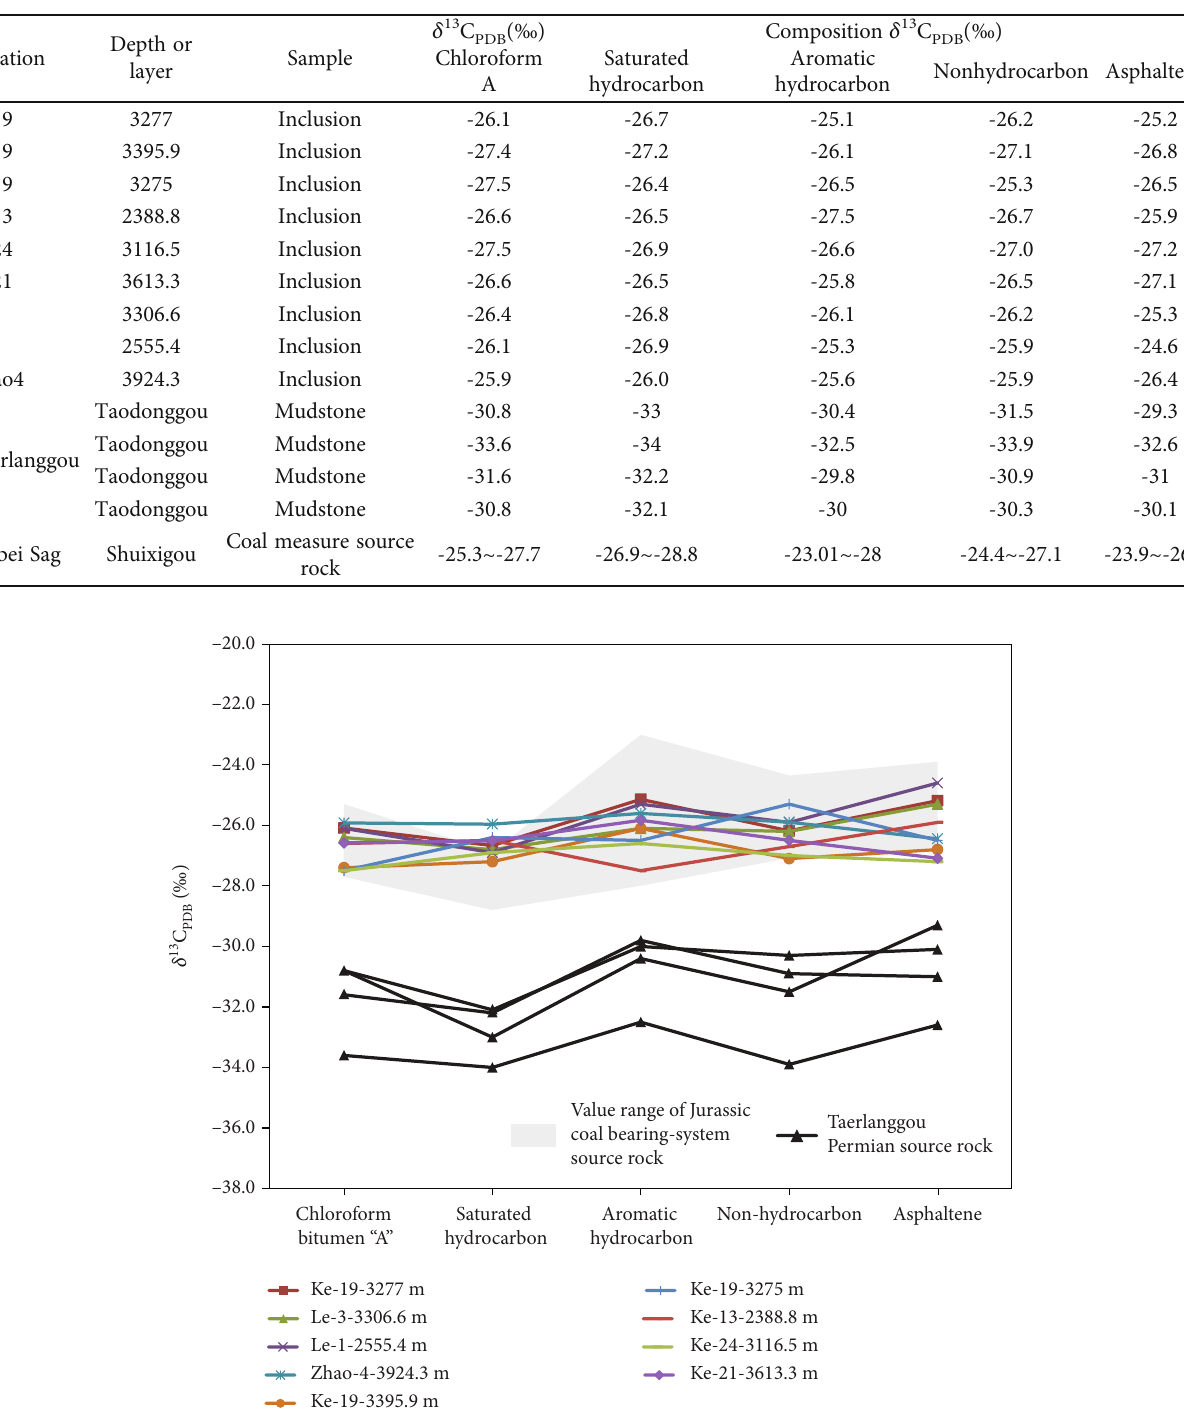
Figure 10: The stable carbon isotope comparison between the group components of the inclusion oil and typical source rock in the northern piedmont belt of the Turpan-Hami